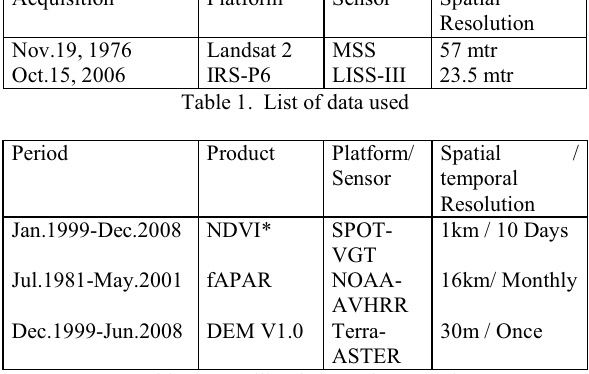
Table 2. Satellite data Products used